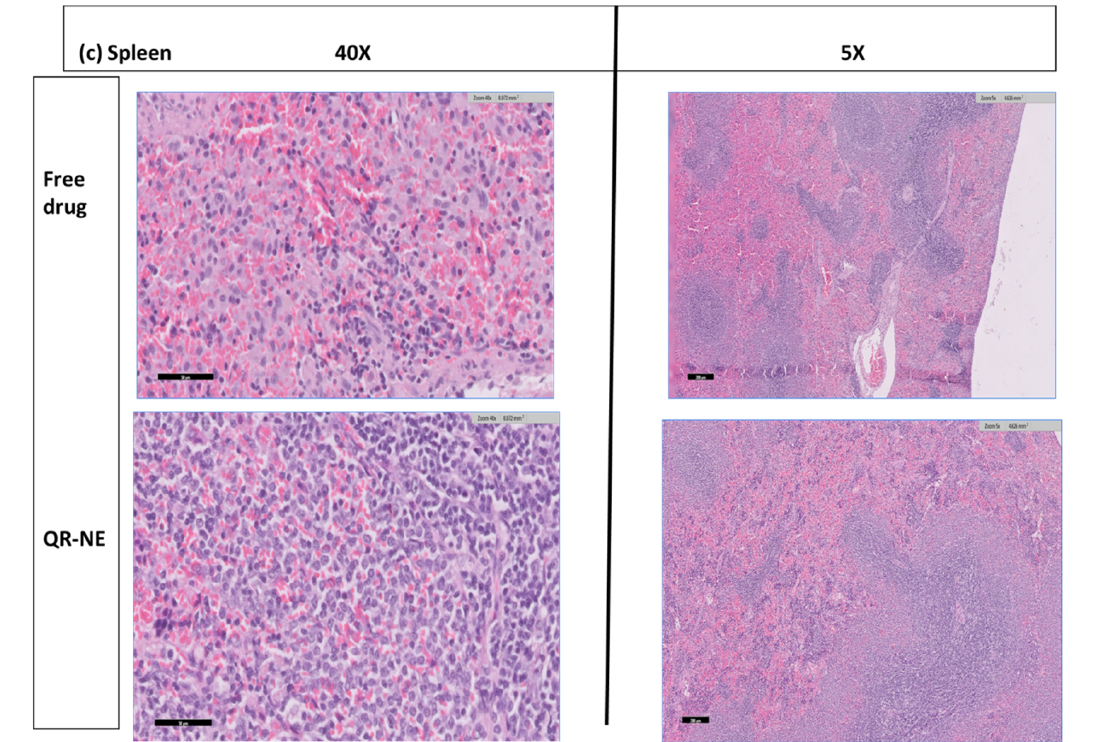
Figure 7. QR-NE safety evaluation on the animal model. Photomicrographs of ( a ) liver, ( b ) kidney, and ( c ) spleen sections after treatment with QR-NE and QR-free drug (H&E staining, magnification 40×, scale bar: 20 μ m and 5×, scale bar: 200 μ m). H&E hematoxylin and eosin sections were all treated with quercetin NE after 14 days. Histological evaluation was performed by ImageJ software version 1.52v.